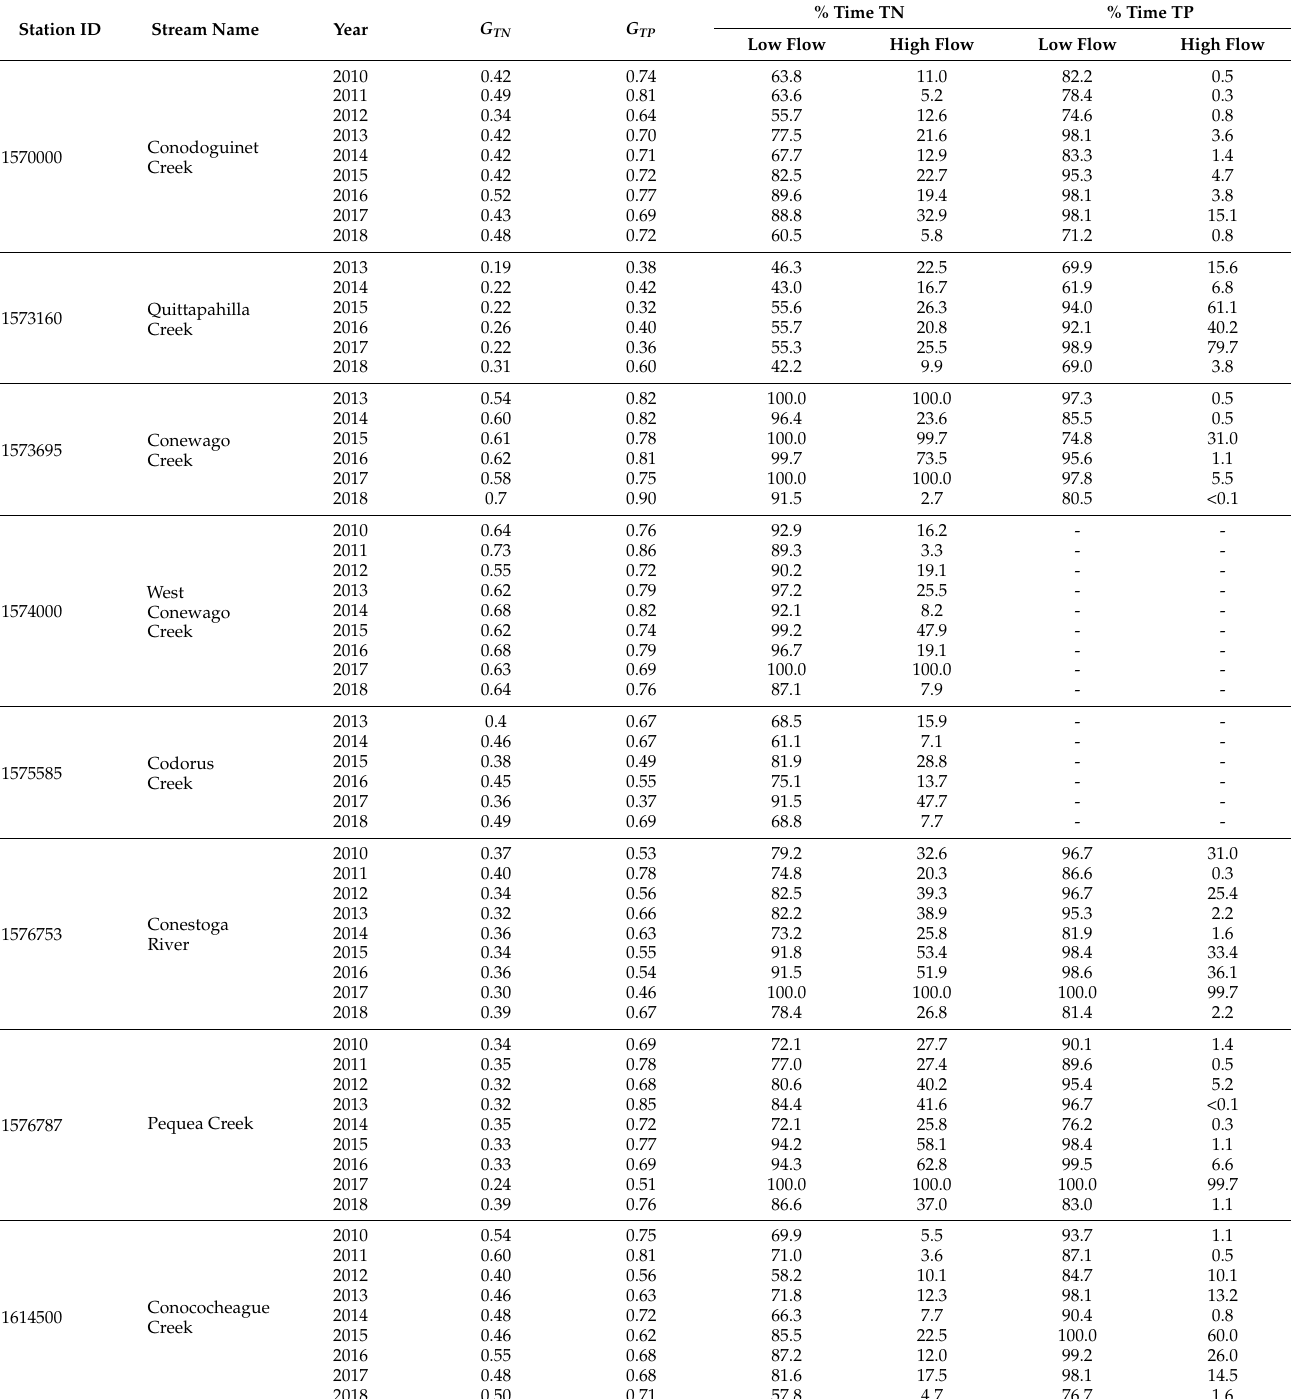
Table 3. Gini Coefficients for total nitrogen ( G TN ) and total phosphorus ( G TP ) loads exported for each year for each selected study site, along with percentages of time that each load is exported during low- and high-flow